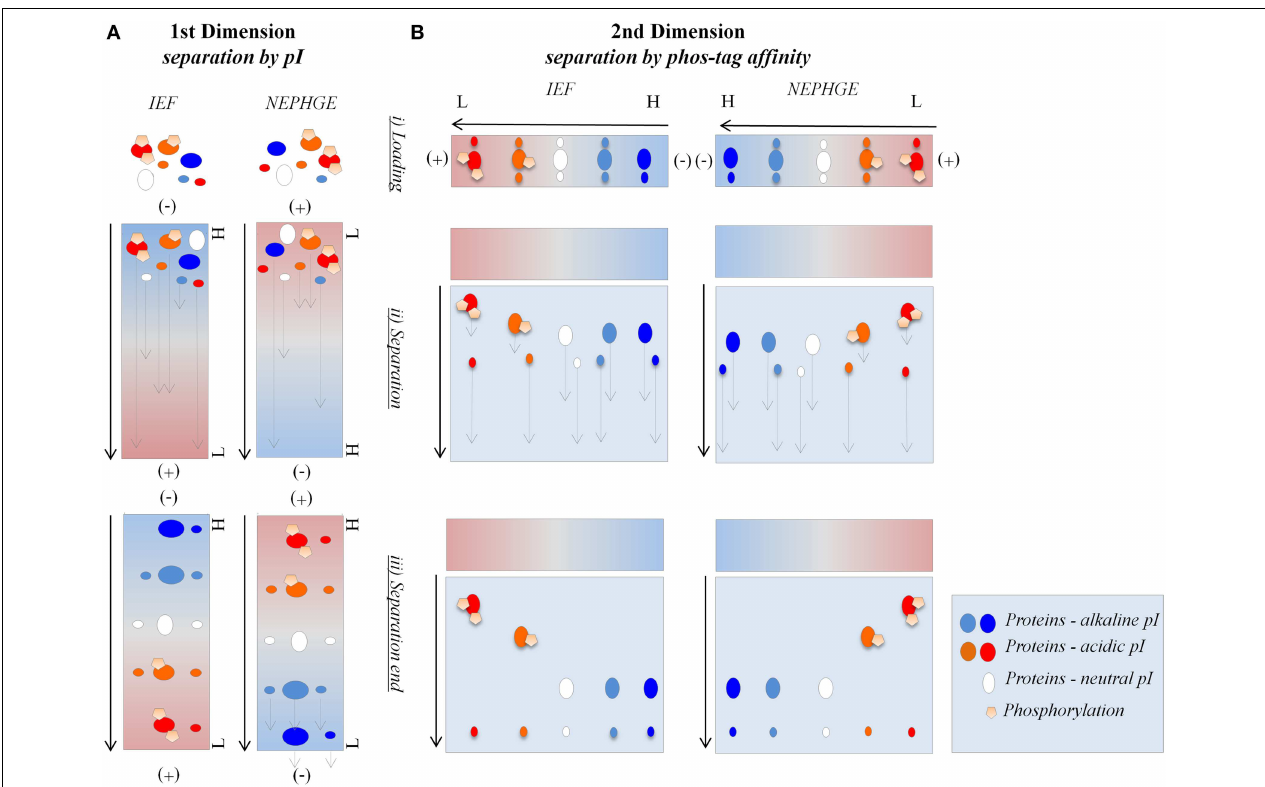
and transferred to the second dimension. (B) In the second dimension proteins were separated by hrCNE due to their molecular weight. Phos-tag hrCNE separated proteins based on their affinity to the phos-tag. Cathode and anode are indicated as ( − ) and ( + ), respectively. An arrow on the left of the gels indicates the direction of separation. Low (L) and high (H) pH are labeled on the right of the first dimensions. Three steps are indicated for first and second dimension: (i) loading the sample, (ii) separation of proteins by electrophoresis, and (iii) final position of the proteins after stopping the